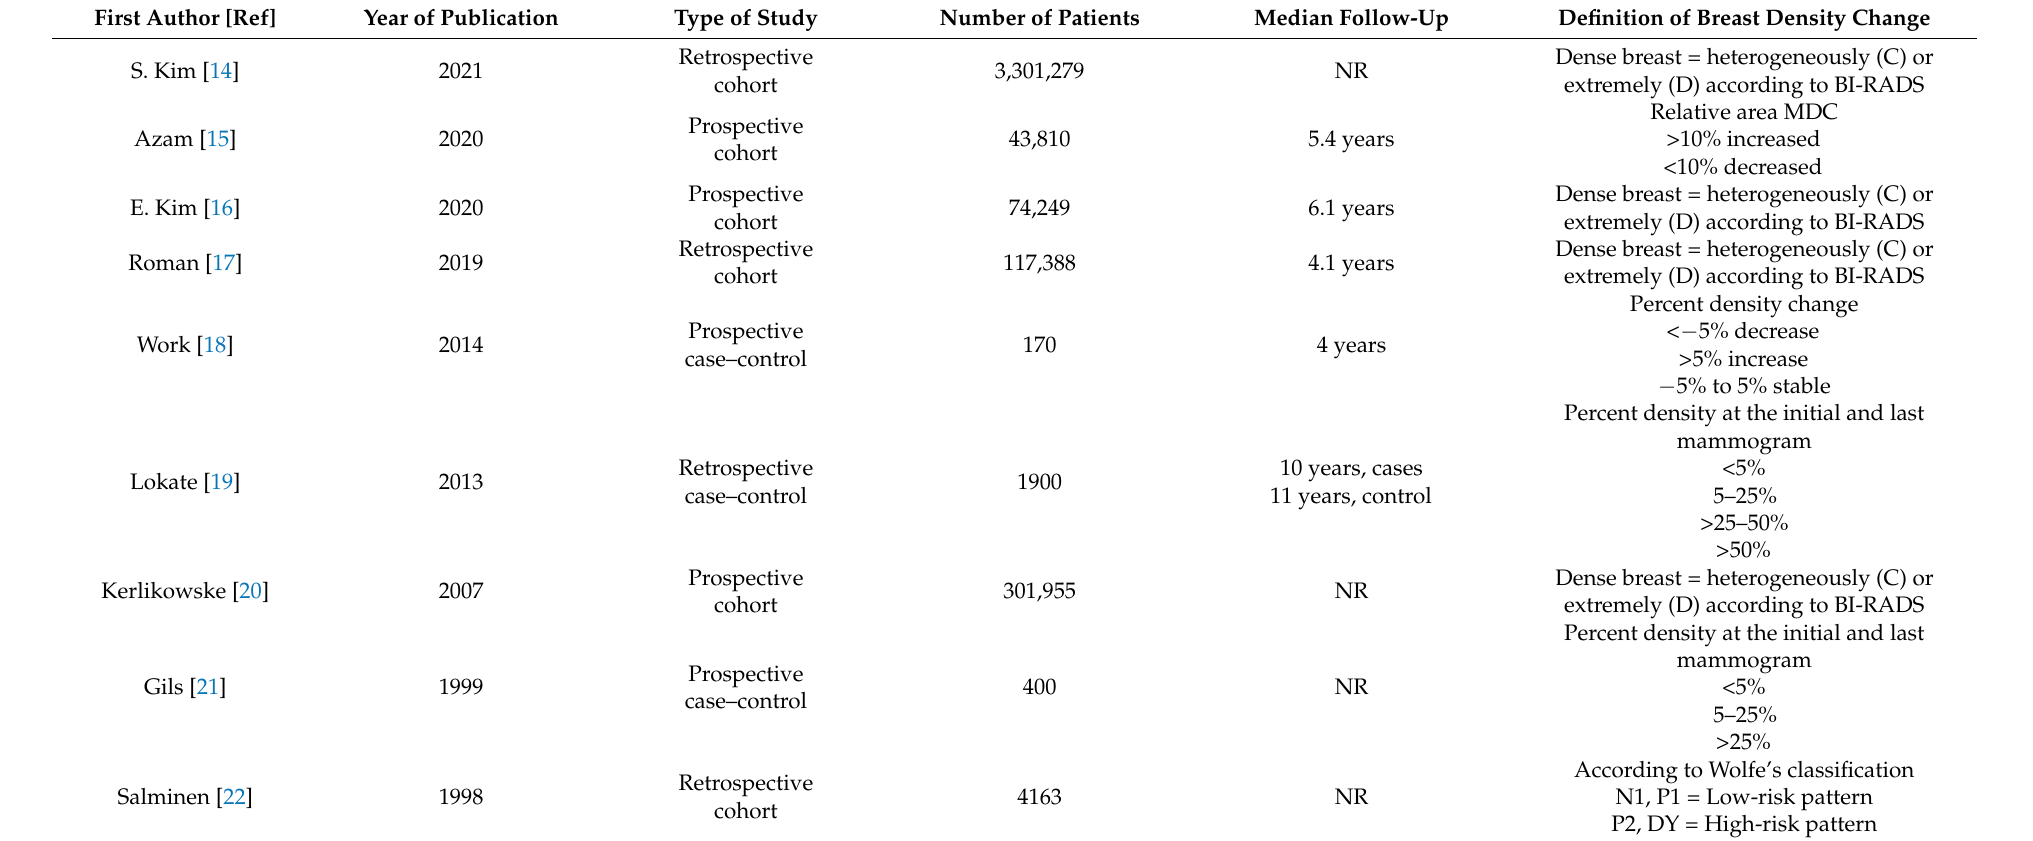
Table 1. Characteristics of eligible